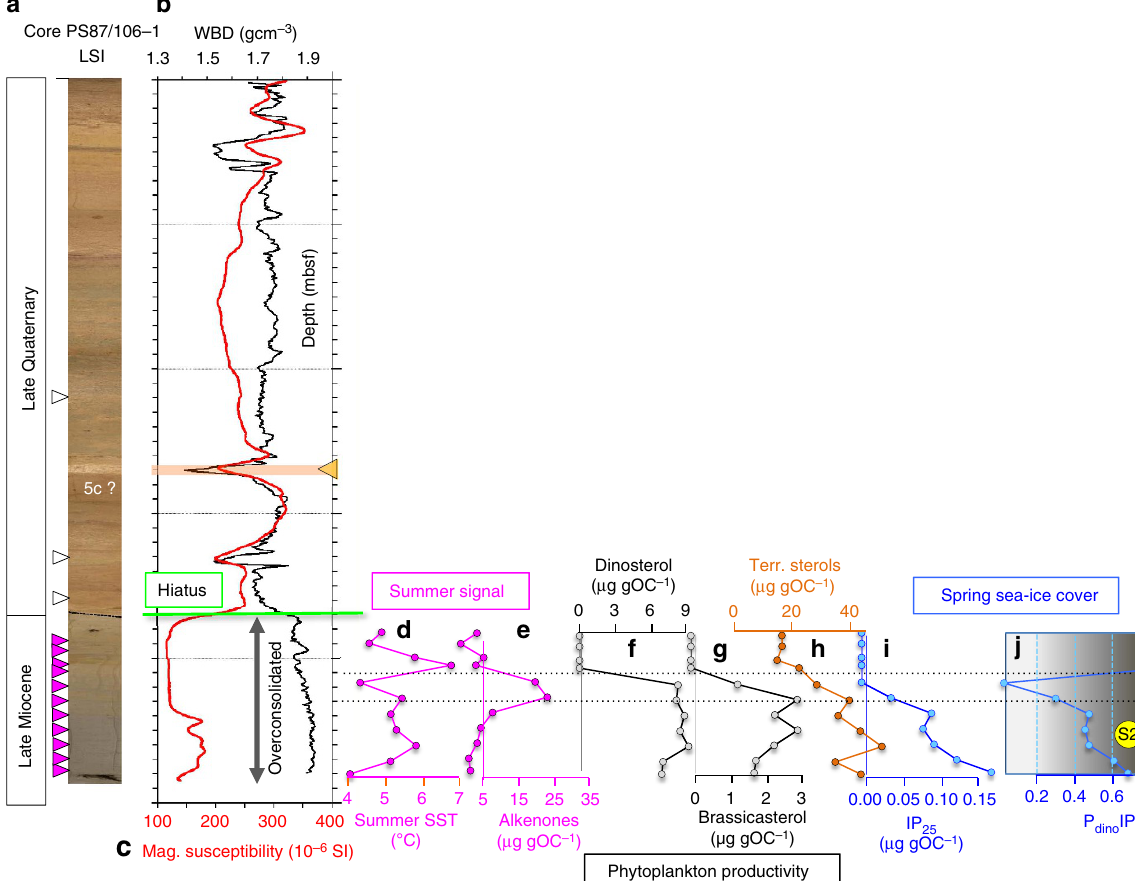
Figure 4 | Proxy evidence from Core PS87/106 for late Miocene Arctic Ocean climate conditions. ( a ) Line-scan image (LSI), ( b ) WBD, ( c ) MS, ( d ) alkenone-based SST, ( e ) concentrations of alkenones, ( f ) dinosterol and ( g ) brassicasterol as proxy for primary productivity, ( h ) concentrations of terrigenous sterols (sum of campesterol and b -sitosterol), ( i ) concentrations of sea-ice proxy IP 25 and ( j ) sea-ice index P dino IP 25 (for data see Supplementary Table 2). Purple and open triangles indicate the presence or absence of alkenones, respectively. Green line marks depth of the hiatus. Below the hiatus, sediments are overconsolidated. Zero or near-zero concentrations of IP 25 and phytoplankton biomarkers are indicative for a closed (spring) sea-ice cover (P dino IP 25 is indetermable and set to ‘1’; see Fig. 1 and Methods for further details). PIP 25 values are used to identify low (0–20%), common (20–50%), ice-edge (50–70%) and extended ( 4 70%) sea-ice concentrations (see Fig. 1). The section below the hiatus represents about one cold (‘glacial’)–warm (‘interglacial’) cycle. S1 and S2 indicate two scenarios of different sea-ice concentrations (that is, maximum and transitional/stable ice edge, respectively) within this climate cycle. The interval between the two dashed horizontal lines marks period with minimum sea-ice cover. Using mean sedimentation rates of B 3.2cmky (cid:2) 1 (as calculated independently from close-by gravity cores 50 and seismic data 51 ), the duration of the climate cycle is B